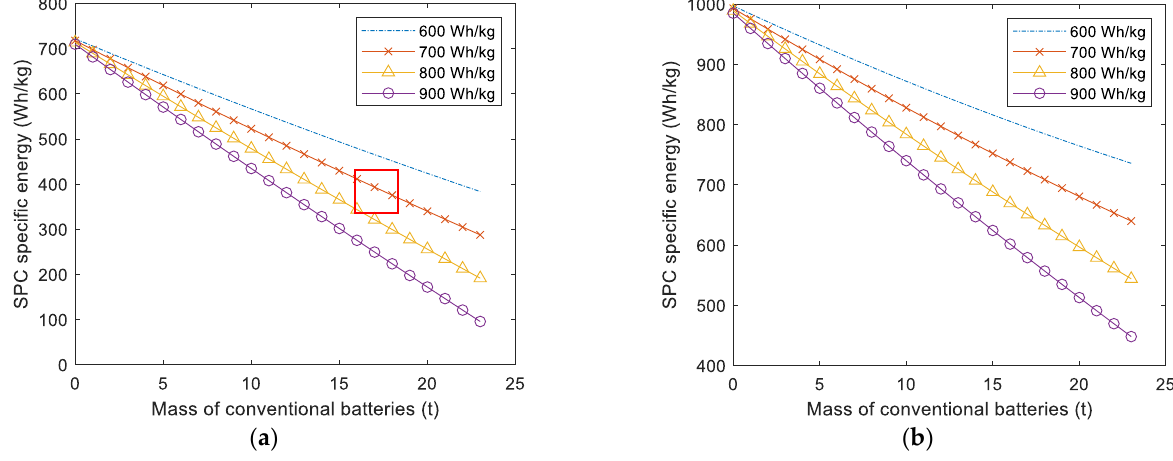
Figure 12. SPC E * requirements for the AEA configuration with different battery pack-level E *. The red box highlights a Figure 12. ( a ) 1000 km range. ( b ) 1500 km range. SPC E * requirements for the AEA configuration with different battery zone which aims to simultaneously minimise SPC and battery E * requirements. pack-level E *. The red box highlights a zone which aims to simultaneously minimise SPC and battery E *